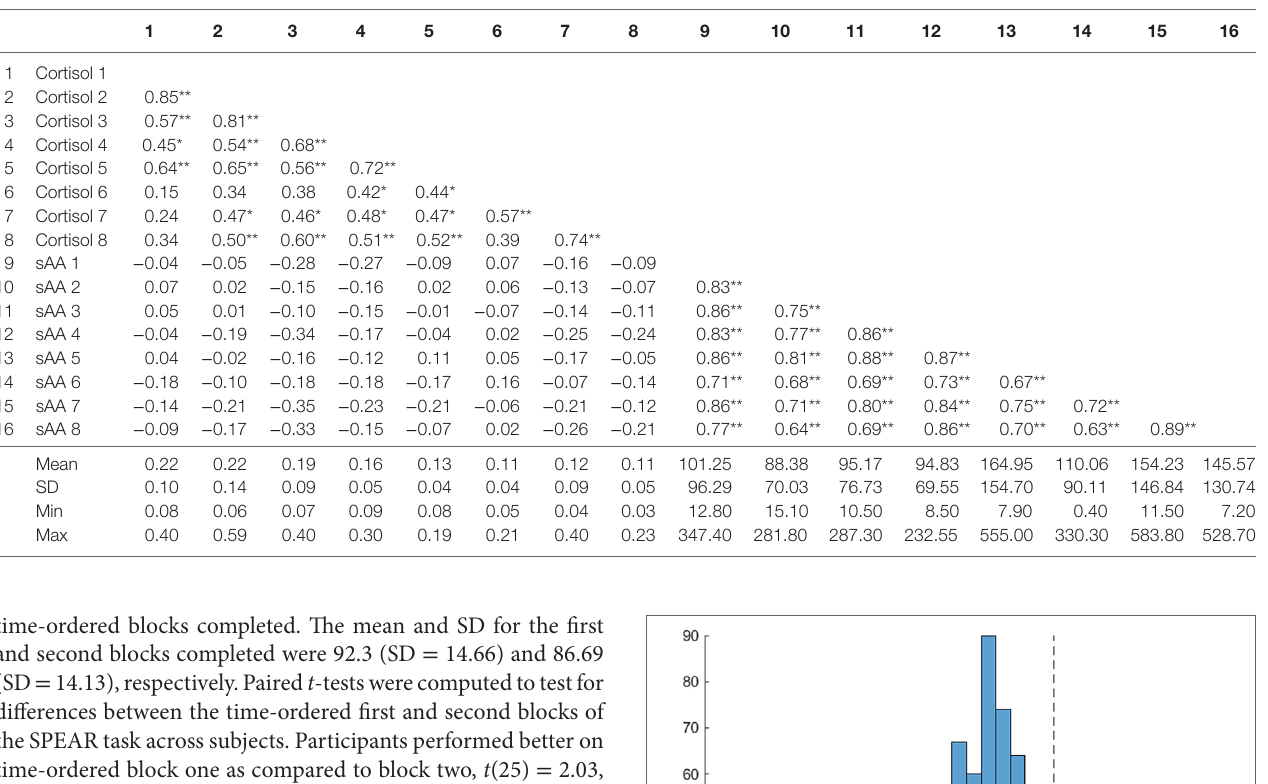
TaBle 1 | Correlations among all cortisol and sAA